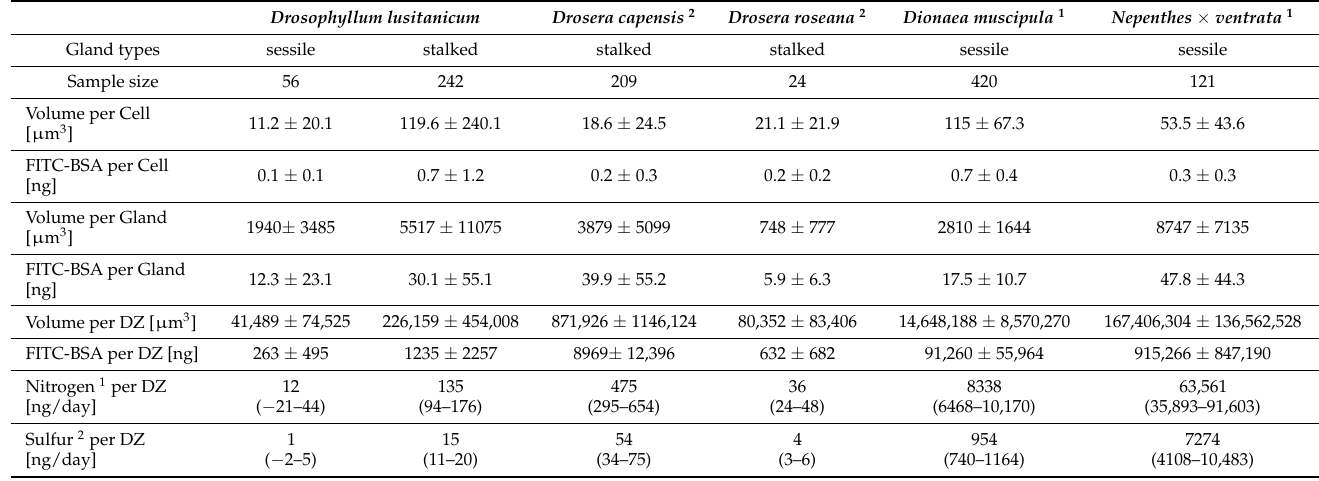
Table 2. Estimated FITC-BSA uptake after 64 h of incubation by vesicle, cell, gland, and DZ, itemized by